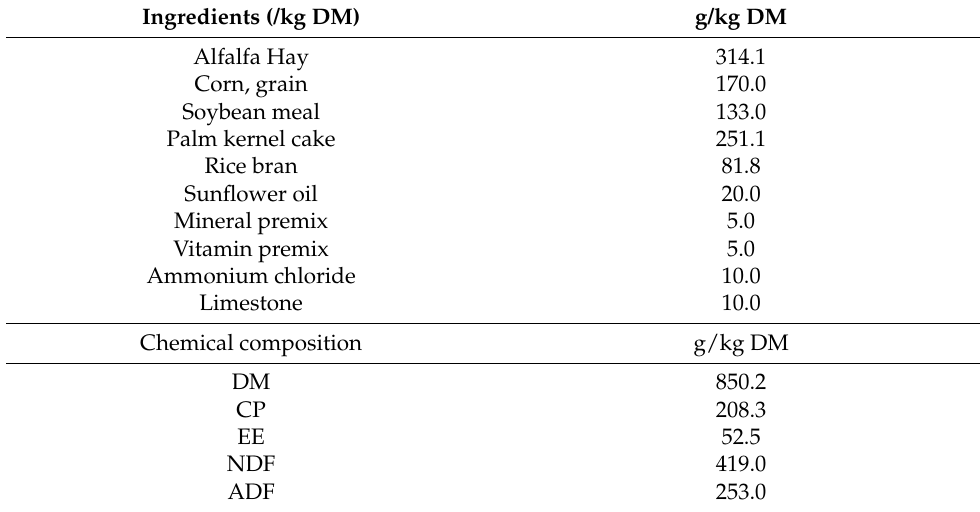
Table 1. Ingredients and chemical composition of the diets fed to the bulls for in vitro